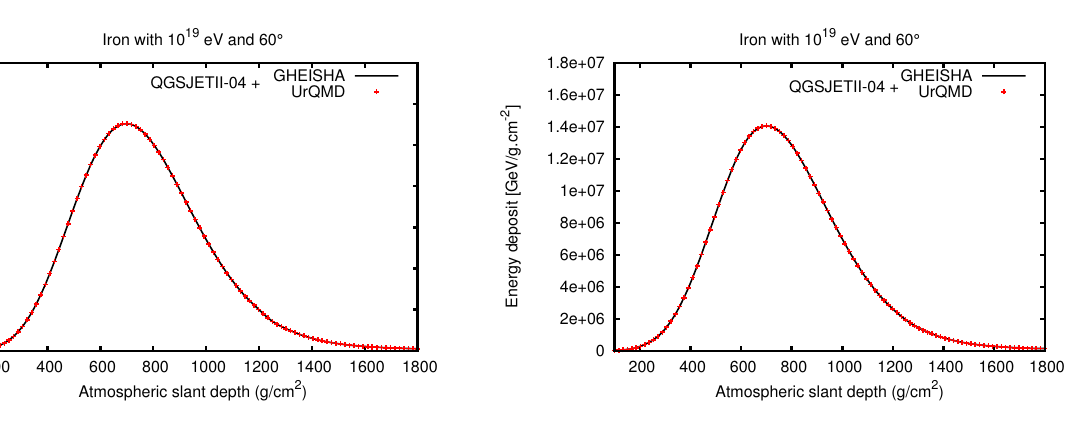
Figure 1. Number of charged particles given by QGSJETII- 04 alternatively combined with low energy hadronic interaction models GHEISHA and UrQMD, for an incoming primary iron with E = 10 19 eV and θ = 60 ◦ .